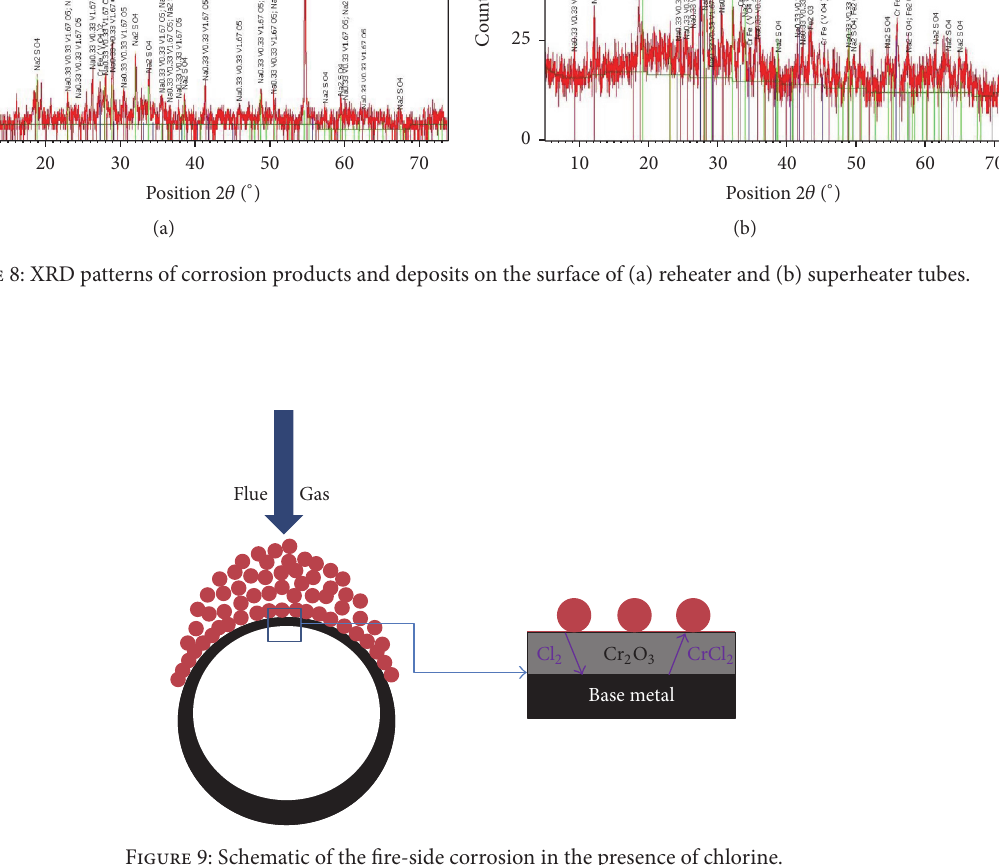
Figure 9: Schematic of the fire-side corrosion in the presence of